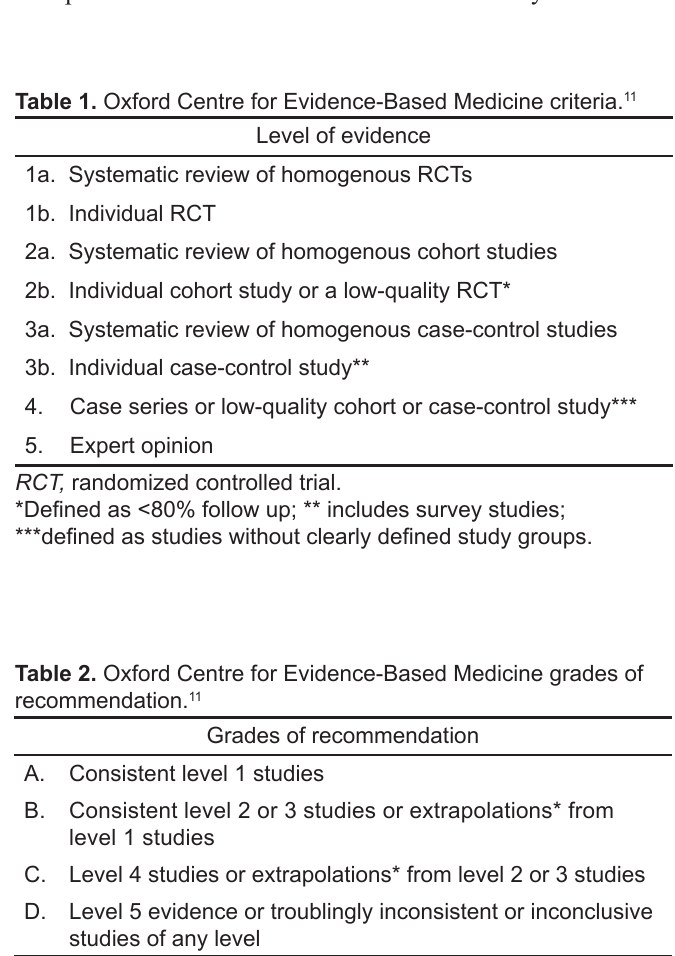
Table 1. Oxford Centre for Evidence-Based Medicine criteria. 11